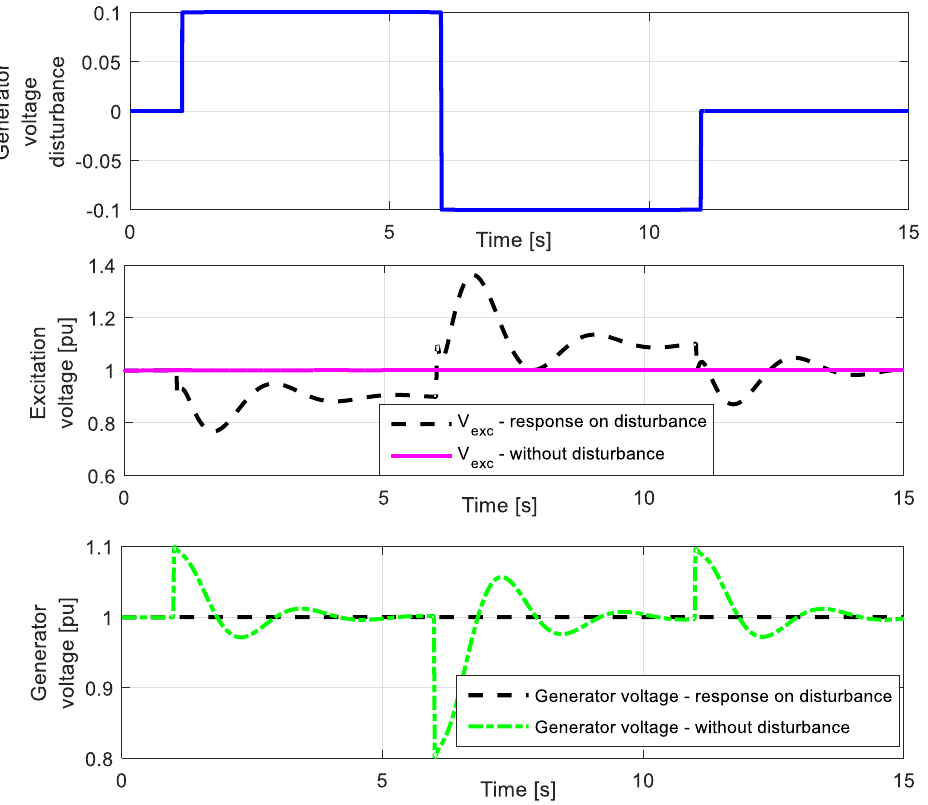
Figure 17. Generator and excitation voltage step response with generator voltage disturbance.